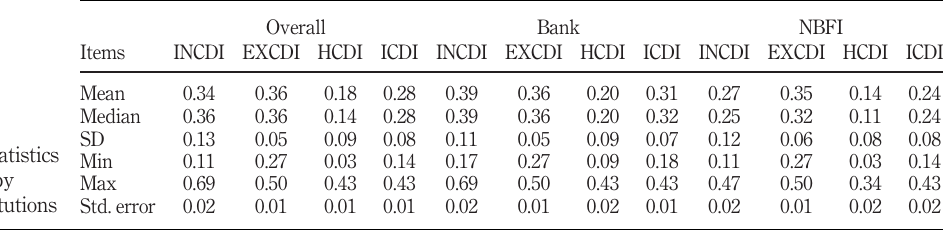
of ICD index by fi nancial institutions